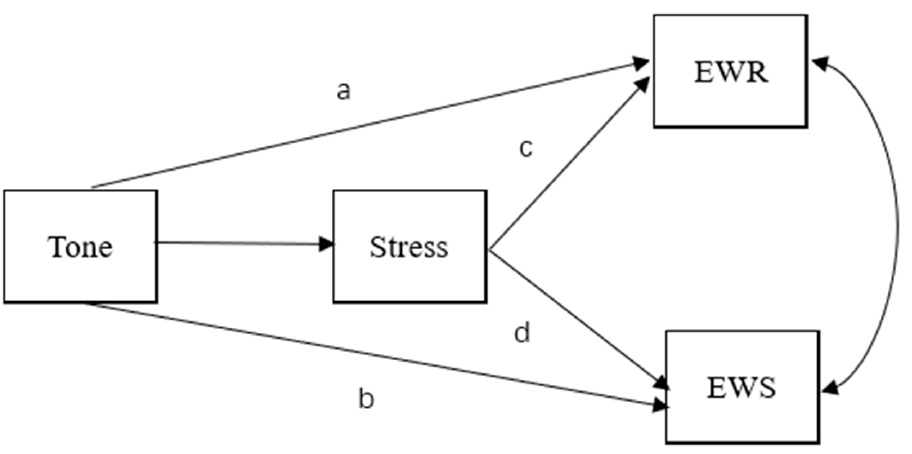
Figure 1. Hypothesized model for the relation between tone, stress, English word reading and spelling. Tone = Chinese tone sensitivity; Stress = English lexical stress sensitivity; Voc = English oral vocabulary; EWR = English word reading; EWS = English word spelling. Direct ways are: ( a ) Tone → EWR; ( b ) Tone → EWS. Indirect ways are: ( c ) Tone → Stress → EWR; ( d ) Tone → Stress → EWS.